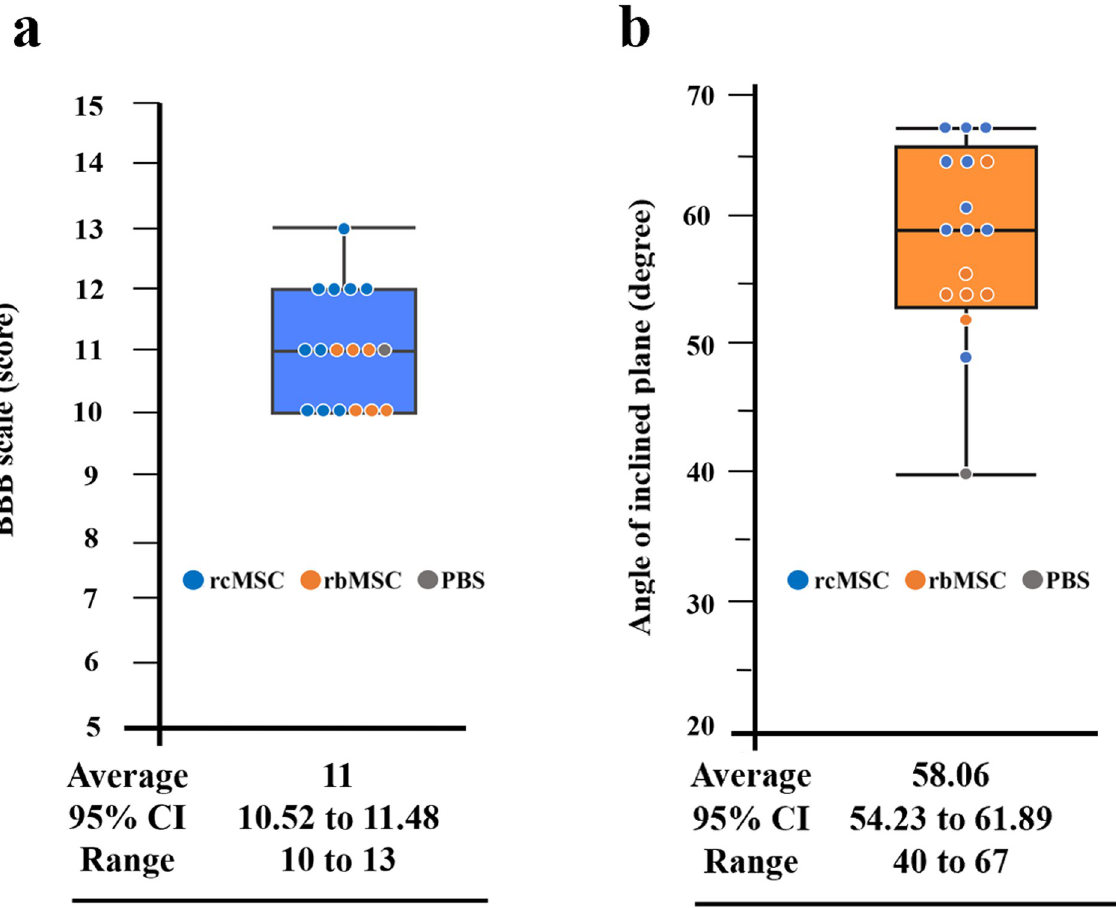
Fig 6. Relationship between the recovery for paralysis and reappearance of the transcranial electrically stimulated motor-evoked potential (tcMEP) waveform. a. Threshold Basso–Beattie–Bresnahan (BBB) scale and b. threshold inclined plane task score. Data are presented as mean ± standard deviation and 95% confidence interval (CI). Results for the rat cranial bone-derived mesenchymal stem cell (rcMSC), rat bone marrow-derived mesenchymal stem cell (rbMSC), and phosphate buffered saline (PBS) groups are indicated by blue, orange, and gray circles,